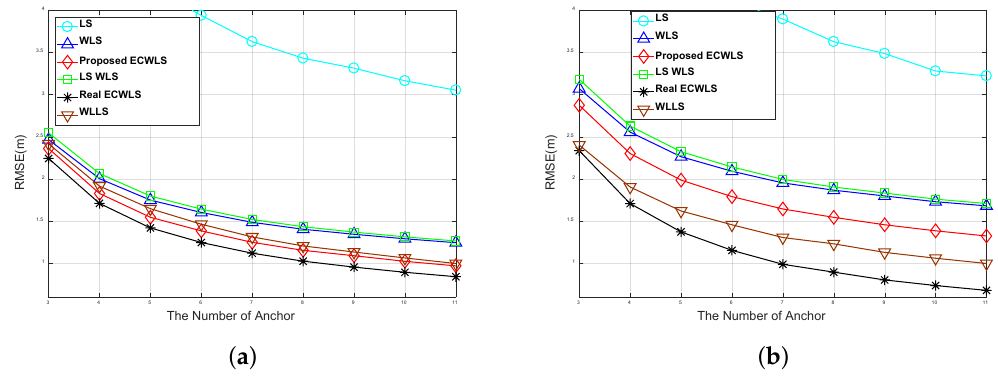
Figure 4. RMSE vs. the number of anchor nodes under noise dispersion with ( a ) slight differences in noise variance and ( b ) large differences in noise